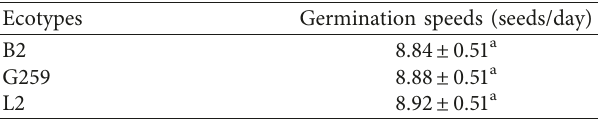
Table 5: Effect of ecotypes on the germination speed of okra seeds.